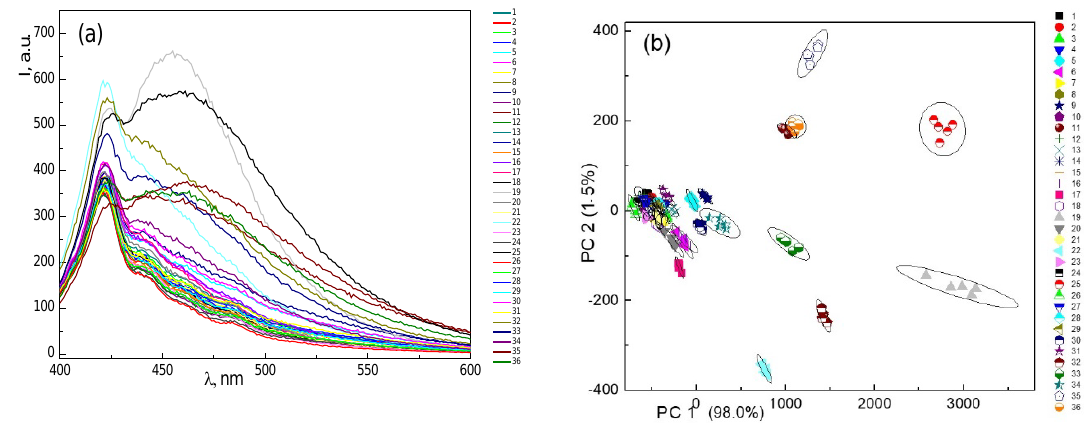
Figure 4. ( a ) Fluorescence spectra of honey samples without added fluorophores, λ ex = 320 nm; ( b ) scores plots of these emission spectra.